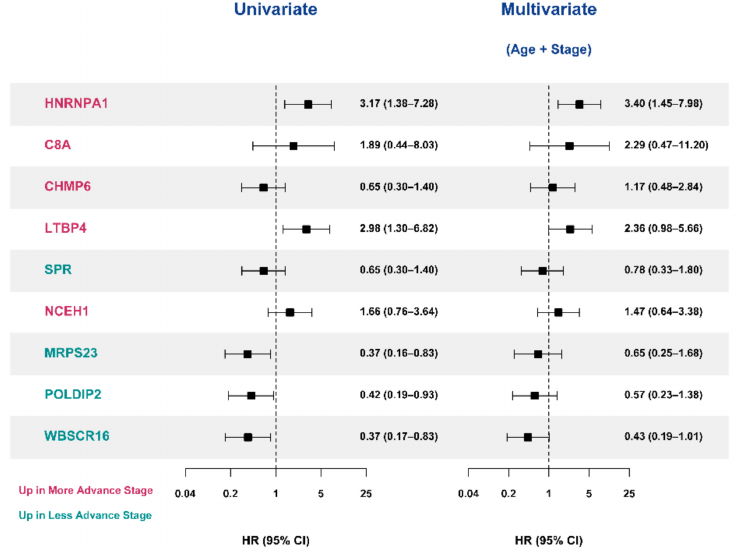
Figure 8. Cox proportional hazard regression models of significant DEPs in TCGA study. Cox proportional hazard regression model analysis was performed on DEPs, which showed a significant difference in survival in the TCGA study. C8A—complement C8 alpha chain; CHMP6—charged multivesicular body protein 6; CI—confidence interval; DEP—differential expression of proteins; HNRNPA1—heterogeneous nuclear ribonucleo-protein A1; LTBP4—latent transform- ing growth factor beta binding protein 4; MRPS23—mitochondrial ribosomal protein S23; NCEH1—neutral cholesterol ester hydrolase 1; POLDIP2—polymerase delta-interacting protein 2; SNUH—Seoul National University Hospital; SPR—sepiapterin reductase; TCGA—The Cancer Genome Atlas; WBSCR16—Williams-Beuren syndrome chromosome region